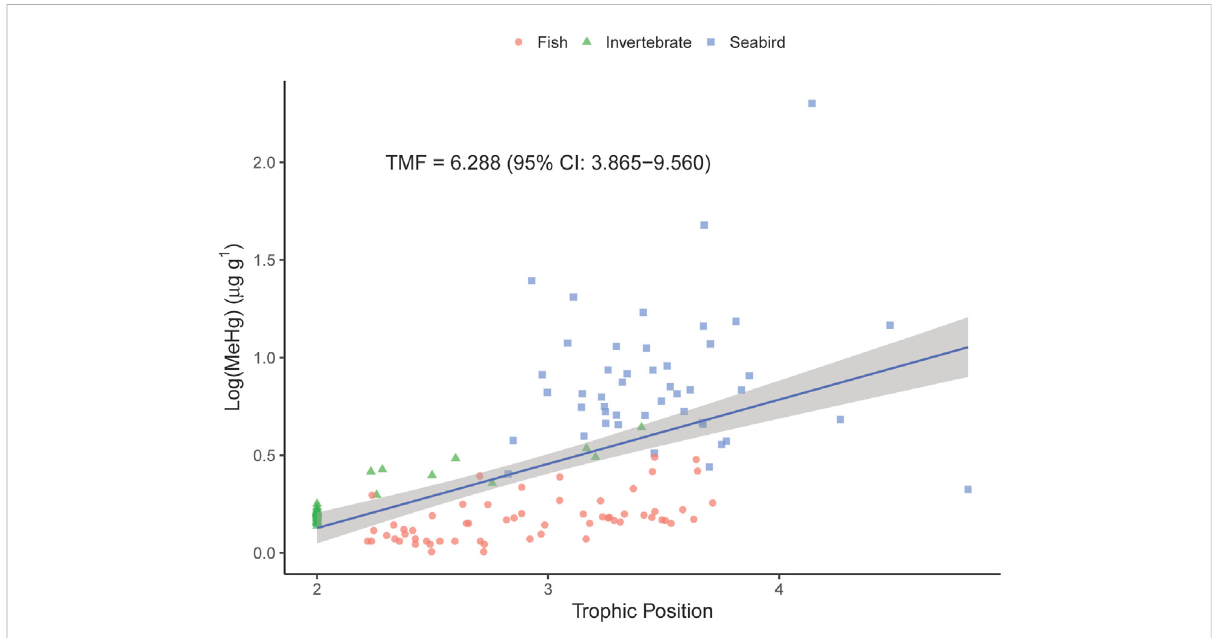
FIGURE 4 The relationship between consumers ’ MeHg (log-transformed) burden and trophic positions in Louisiana. The overall fi t of the line is represented by the grey shaded area. Trophic magni fi cation factors (TMF) are derived from the anti-log of the slope coef fi cient and indicate biomagni fi cation is occurring when values exceed